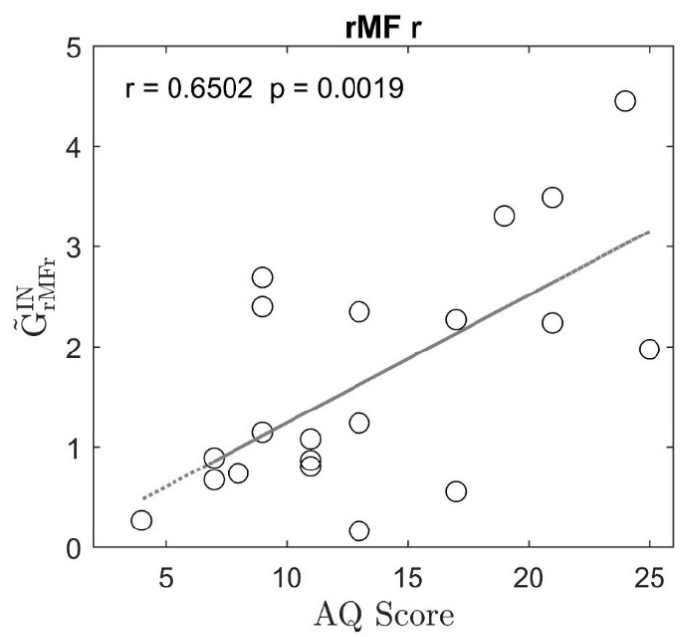
Figure 2. Plot of the regression line between the sum of the normalized connections entering a given region (input sum (cid:102) GC (cid:3010)(cid:3015) ) and the Autism Spectrum Quotient (AQ) score, obtained using data from 20 participants. Only plots in the region that exhibit a correlation coefficient higher than 0.4, with a significant p value for the correlation and a significant difference between the two classes, are shown. In the plot, the regression coefficient and the p value for testing the hypothesis of no-correlation are shown in the label. It is worth noting that to obtain this plot, the connection matrix for each participant was normalized so that the total sum of connection strength was as high as 100 (see Equations (4), (5) and (7)); hence, for example, a value of 3 on the y -axis indicates that 3% of the total connections in the network are entering that particular ROI. Hence, the values in the plot summarize whether the connections entering the node are stronger (high value) or weaker (low value) compared to the total sum of the connections in the same